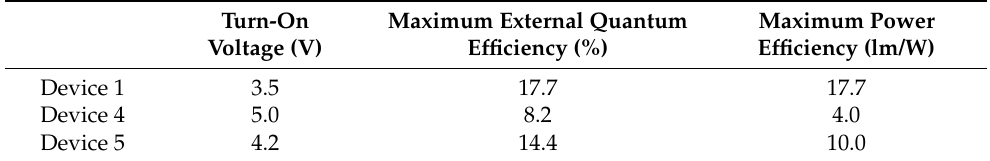
Figure 4. ( a ) J-V-L characteristics and ( b ) J-EQE characteristics of devices 1, 4, and 5. Table 5. EL characteristics of devices 1, 4, and 5.